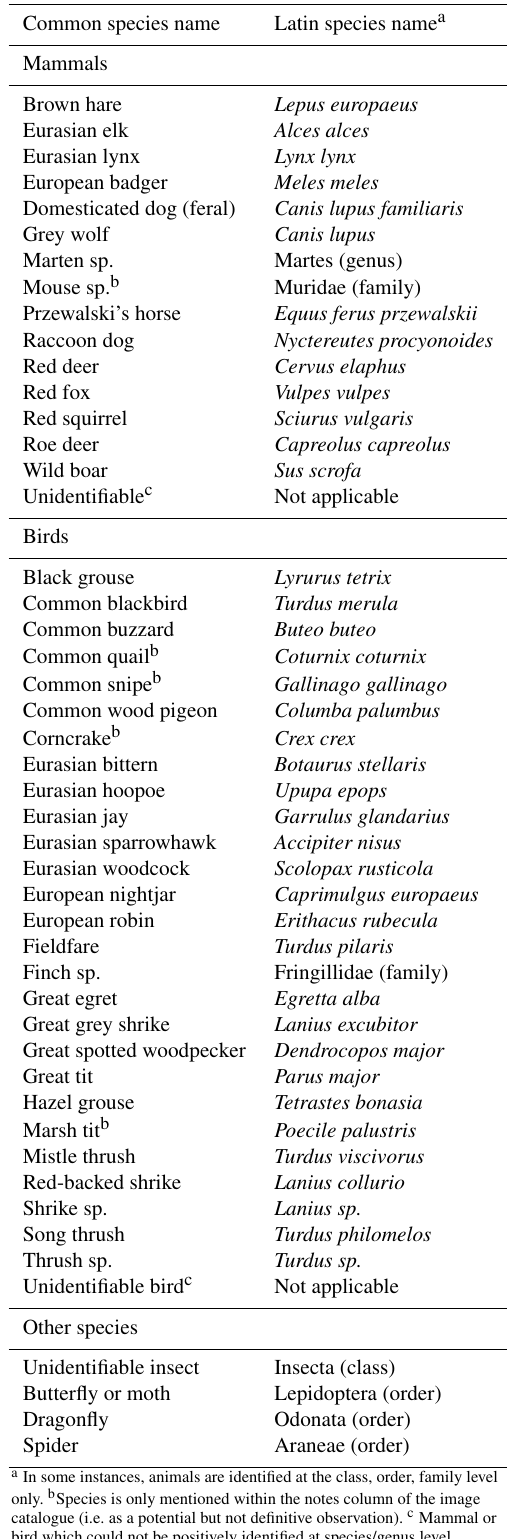
Table 1. Species captured on the motion-activated digital trap cam-